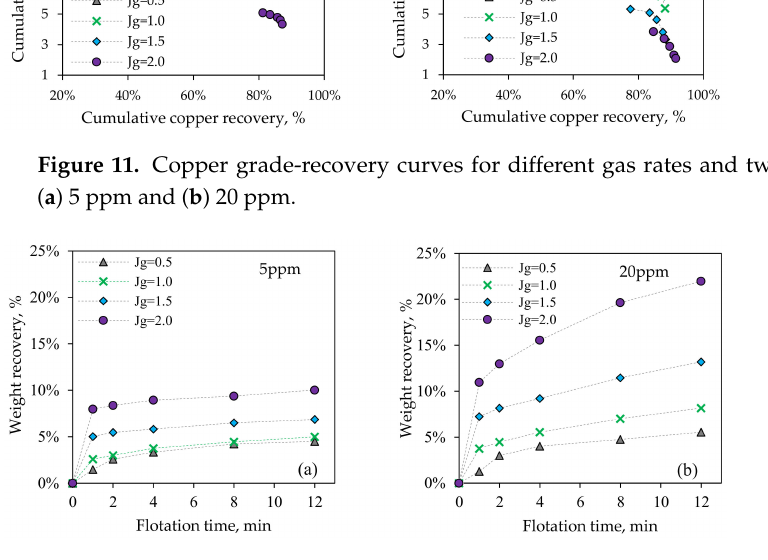
Figure 12. Weight recovery for different gas rates and two frother concentrations: ( a ) 5 ppm and ( b ) 20